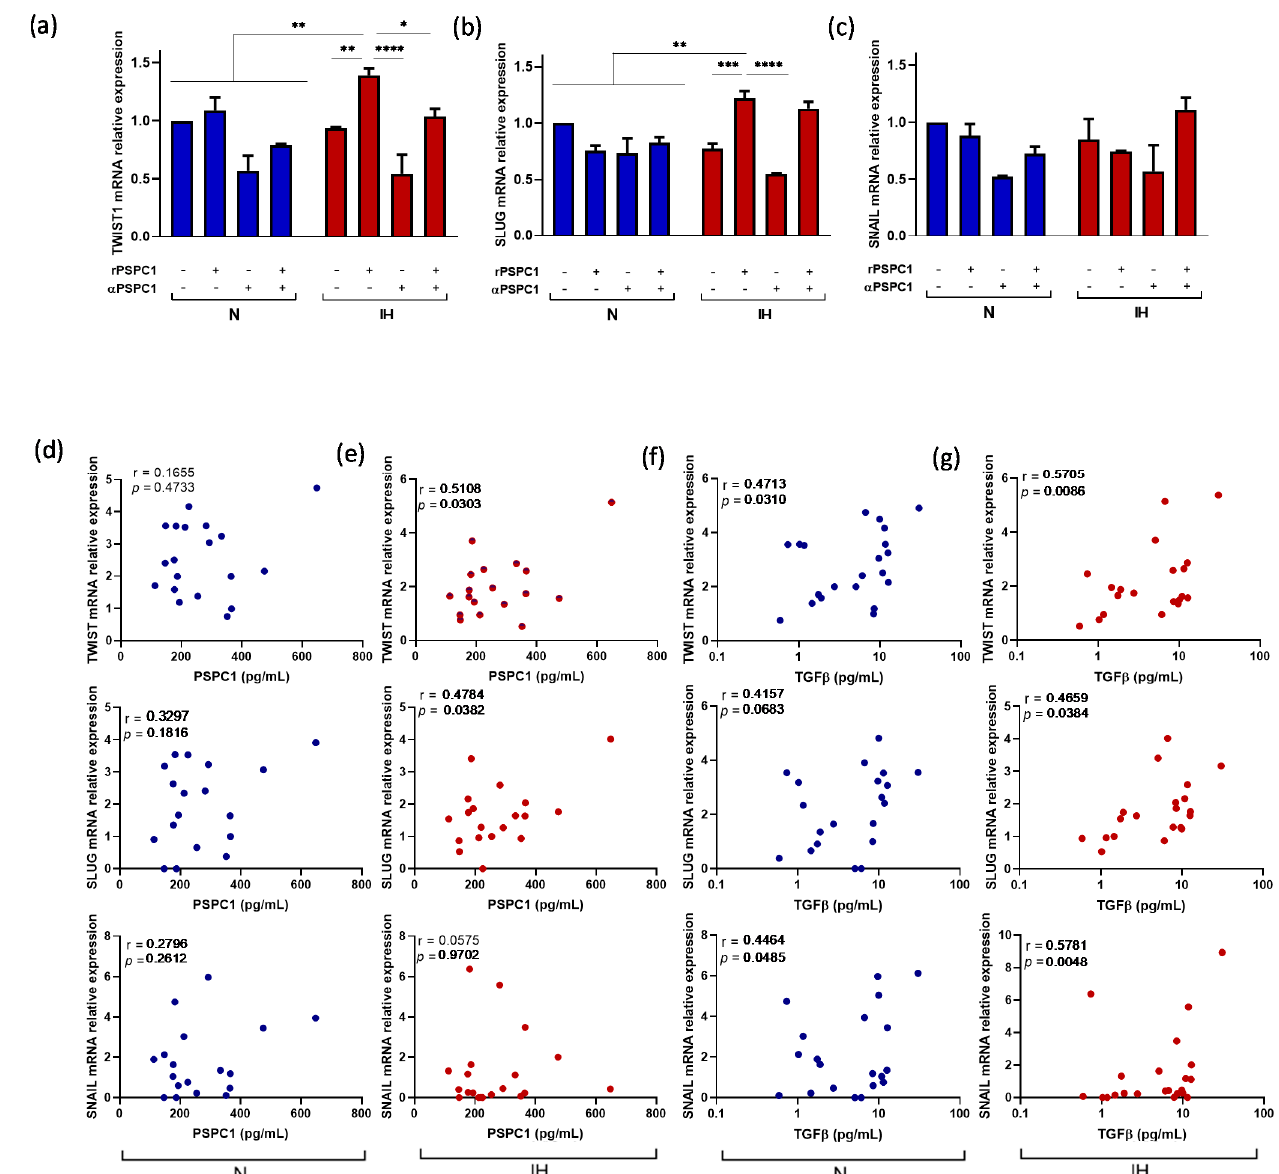
Figure 4. Effect of PSPC1 on EMT-TFs expression in a melanoma cell line. The melanoma cell line (C-8161) was cultured under N and IH conditions with rPSPC1 protein (2.5 ng/mL) with or without α -PSPC1 (1 ug/mL) for 16 h. The melanoma cells were then harvested to analyze TWIST ( a ), SLUG ( b ), and SNAIL ( c ) mRNA expression by qPCR. The groups were compared using a two-way ANOVA. Error bars: SEM. * p < 0.05, ** p < 0.01, *** p < 0.001, and **** p < 0.0001. The melanoma cell line (C-8161) was cultured under IH and N conditions with plasma from randomly selected patients with severe OSA (10% concentration) for 16 h. The melanoma cells were then harvested to analyze TWIST, SLUG, and SNAIL mRNA expression by qPCR analysis. The correlation between PSPC1 protein concentrations from OSA plasma supplemented to the cell culture with mRNA expression of EMT-TFs in N ( d ) and IH ( e ) conditions are shown. The correlation between TGF β protein concentrations from OSA plasma supplemented to the cell culture and mRNA expression of EMT-TFs in N ( f ) and IH ( g ) conditions are shown. Pearson’s correlation coefficients (r) and p -values are shown.